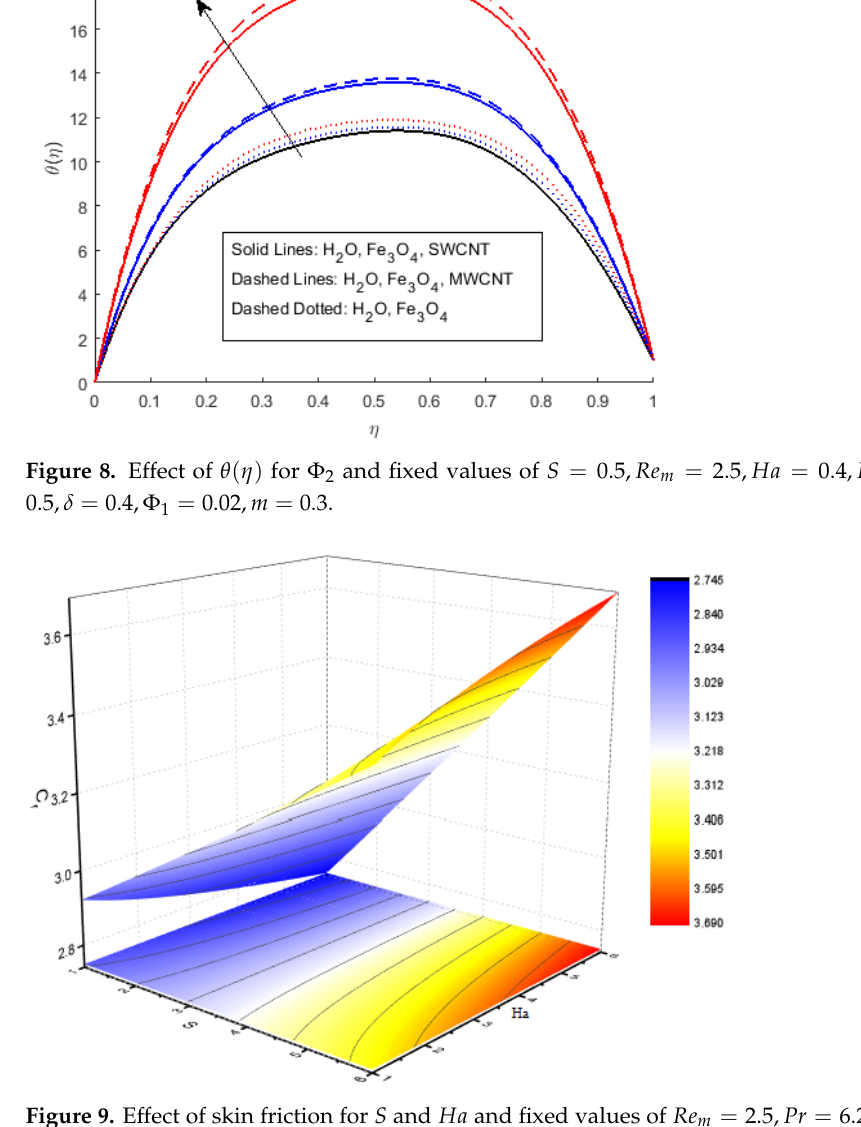
Figure 9. Effect of skin friction for S and Ha and fixed values of Re m = 2.5, Pr = 6.2, Ec = 0.5, δ = 0.4, Φ 1 = 0.02, m =